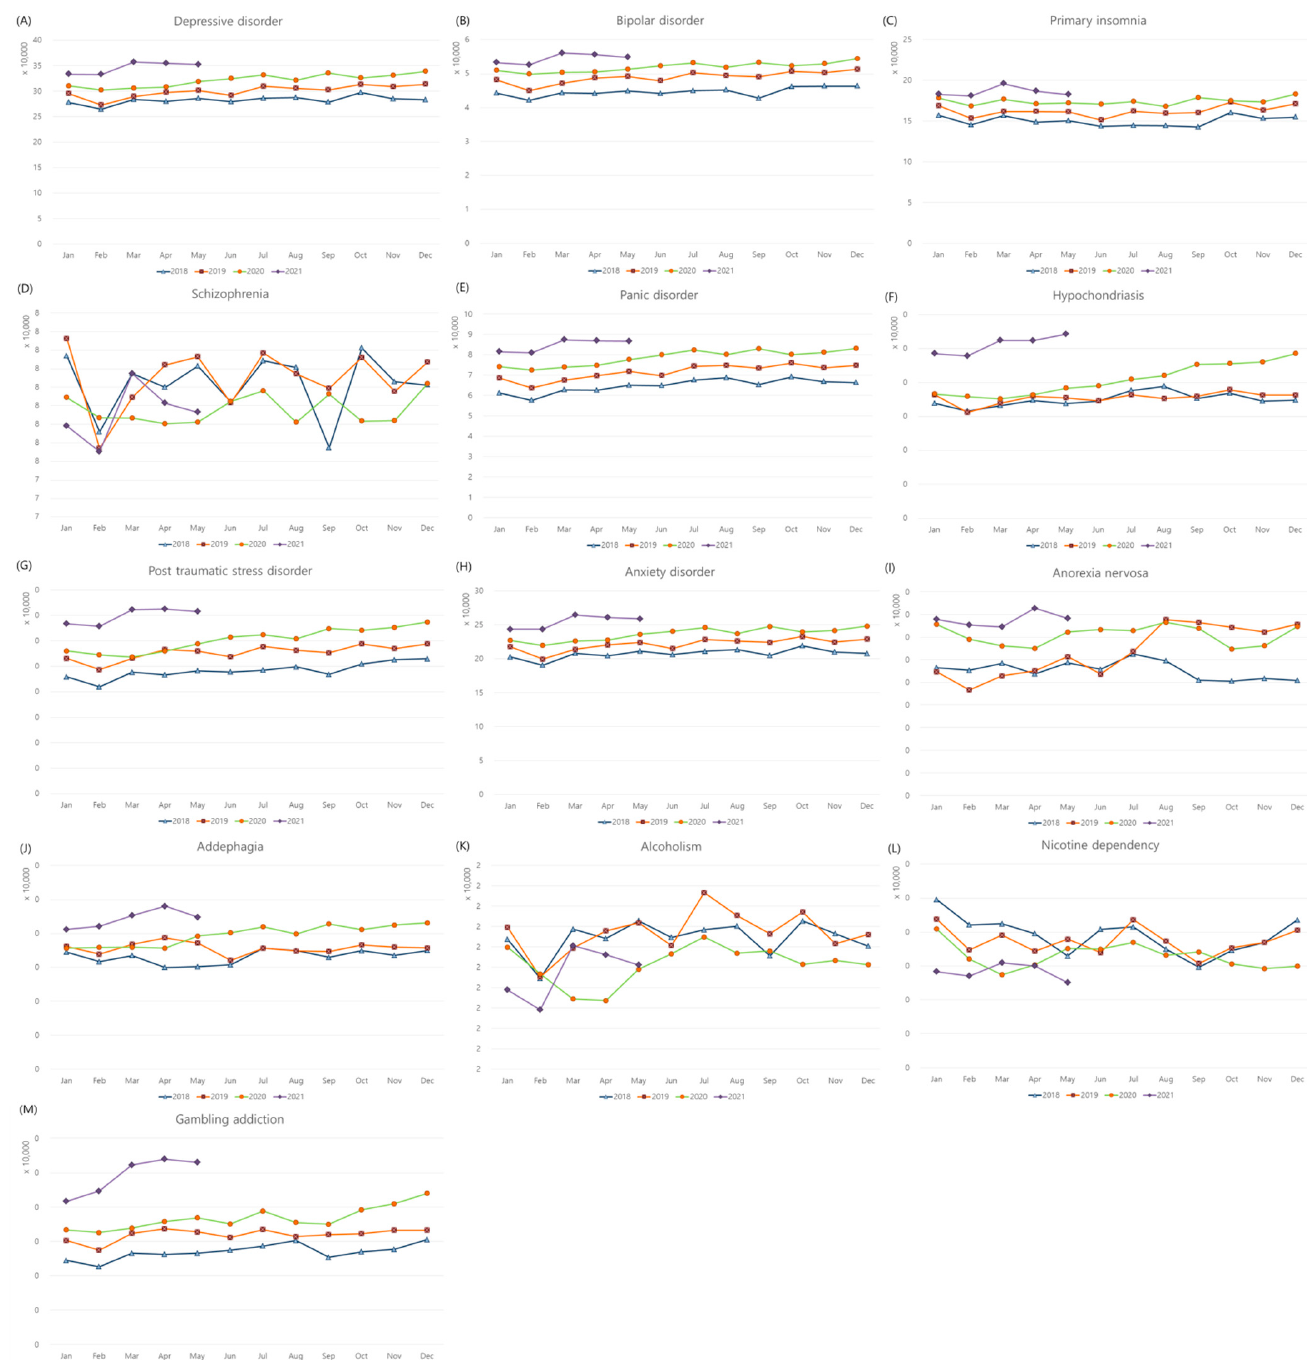
Figure 1. Monthly medical visits for psychological diseases in 2018, 2019, 2020, and 2021. The incidences of ( A ) depressive disorder, ( B ) bipolar disorder, ( C ) primary insomnia, ( D ) schizophrenia, ( E ) panic disorder, ( F ) hypochondriasis, ( G ) posttraumatic stress disorder, ( H ) anxiety disorder, ( I ) anorexia nervosa, ( J ) addephagia, ( K ) alcoholism, ( L ) nicotine dependency, and ( M ) gambling